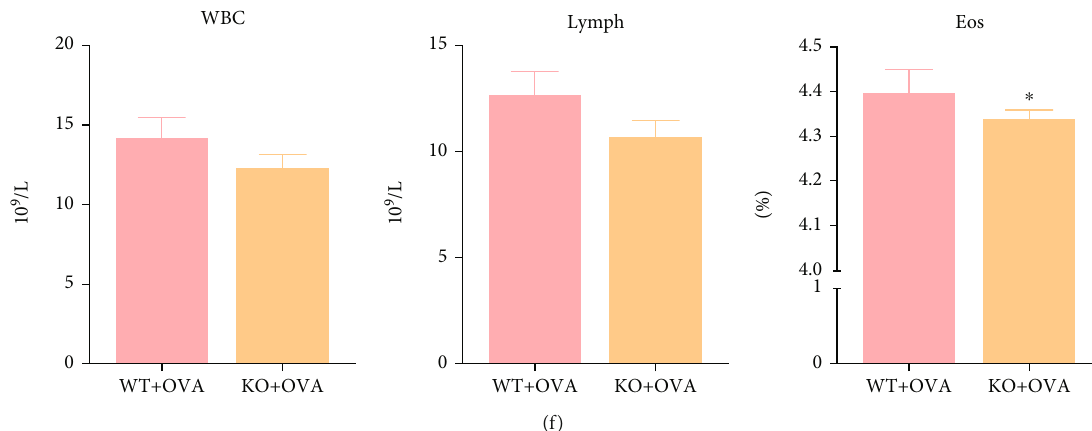
Figure 1: CD226 de fi ciency signi fi cantly attenuates OVA-induced allergic symptoms in AR. (a) Experimental design of the mouse model of AR. (b, c) Frequency of nasal rubbing and sneezing ( n = 5 ) within a 10min period after OVA challenge. (d, e) Serum levels of OVA-speci fi c IgE ( n = 6 ) and histamine ( n = 9 ) detected using ELISA. (f) Routine blood tests of WBC, Lymph, and Eos ( n = 7 ). AR: allergic rhinitis; OVA: ovalbumin; NS: normal saline; IgE: immunoglobulin E; alum: aluminum hydroxide; i.p.: intraperitoneal; i.n.: intranasal; WT: wild type; KO: knockout; WBC: white blood cells; Lymph: lymphocytes; Eos: eosinophils. ∗ P < 0 : 05 , ∗∗ P < 0 : 01 , and ∗∗∗ P < 0 : 001